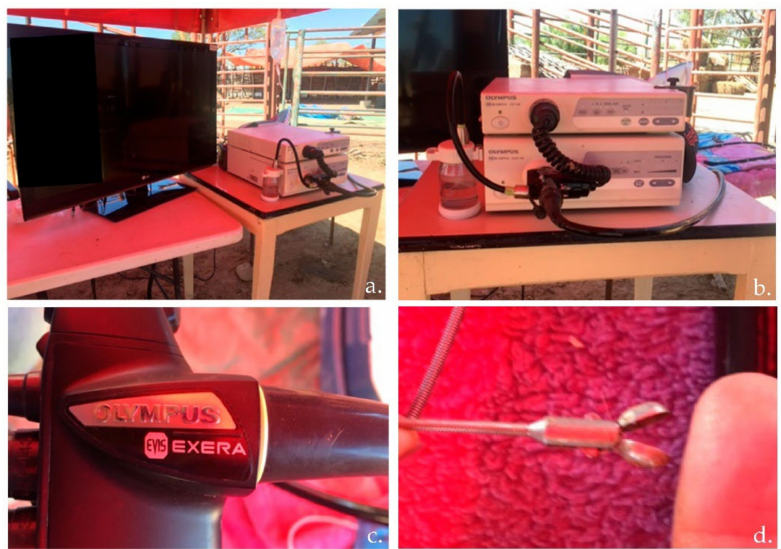
Figure 2. Rumen oral endoscopic biopsy equipment: ( a ) monitor and video system center; ( b ) light source, suction pump, and water container; ( c ) Olympus ® Evis Exera endoscope; and ( d ) biopsy